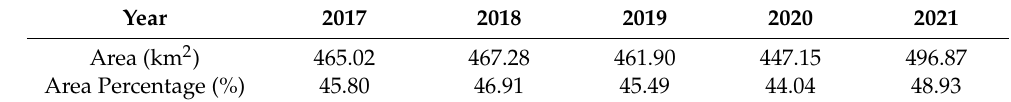
Table 5. Statistics of the impervious surface area in the central city of Jinan, 2017–2021.